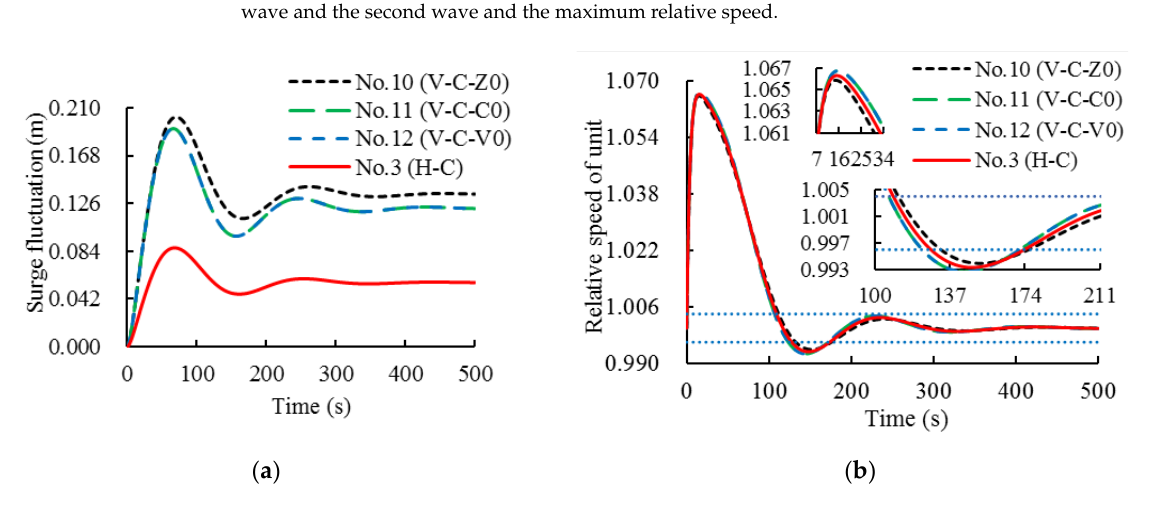
Figure 5. Comparison of horizontal and vertical ACSCs under SLD Condition C: ( a ) Surge varying with time; ( b ) Relative unit speed varying with time.